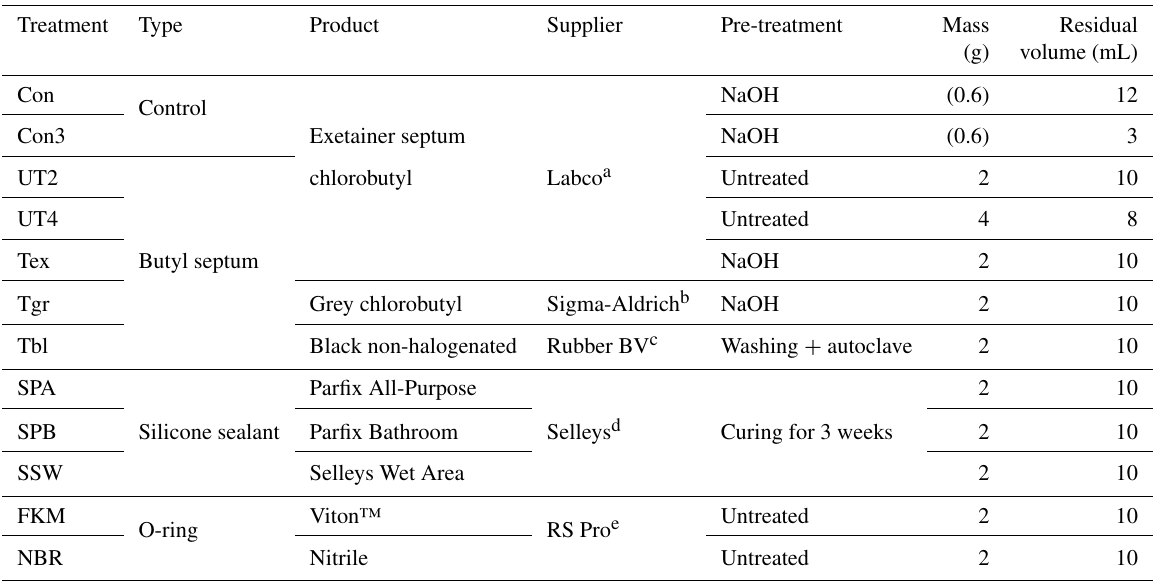
Table 1. Treatments for testing rubber materials for H 2 and CO release. The control treatments consisted of empty Exetainers; the other treatments contained the listed amount of material, excluding the approximately 0.6g of pre-treated Exetainer septa used for sealing all treatments and controls.